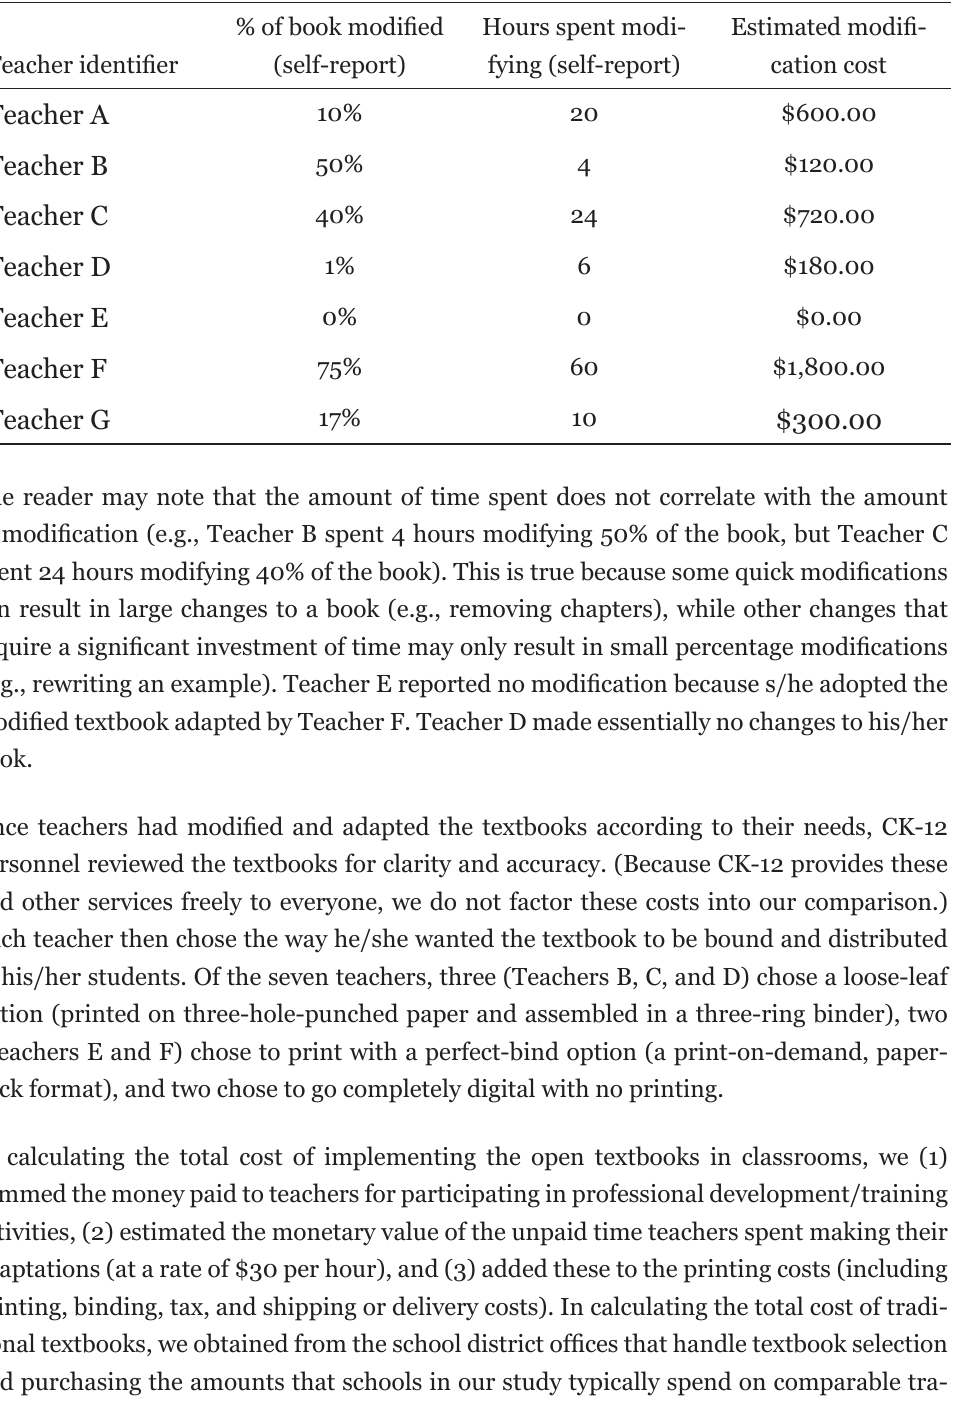
Table 1 Summary of Teacher Efforts to Modify Open Textbooks